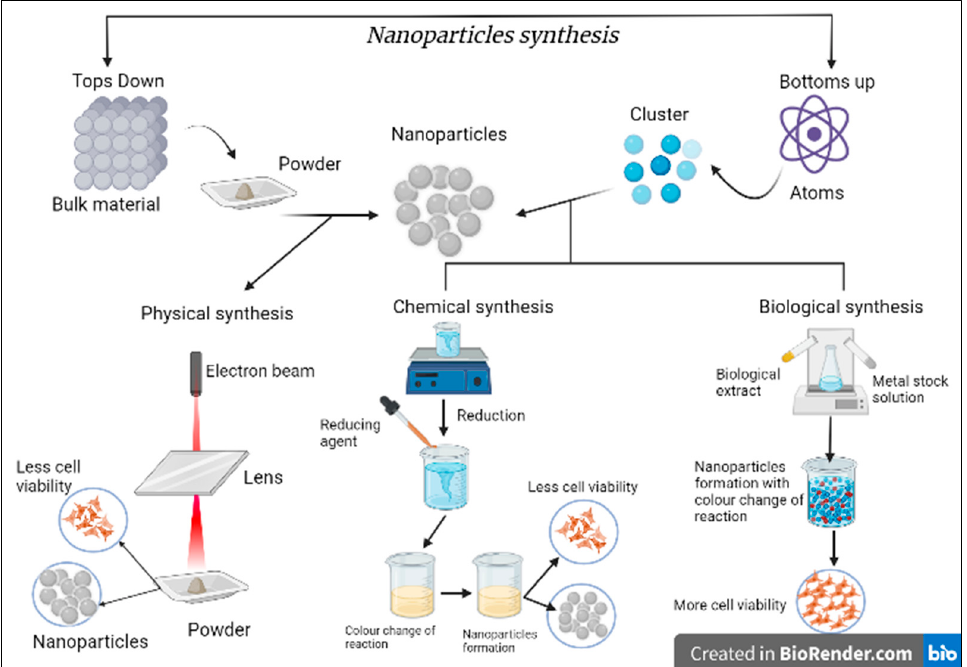
Figure 1. In brief, the AgNPs synthesis process by different synthesis approaches. The figure explains the top-down and bottom-up methods in detail. In the top-down method, it breaks down the bulk material into powder, and then this powder is used in the physical method of NP synthesis by laser ablation method. However, due to the toxicity, the cell viability is less. Likewise, in the bottom-up method, the atom form of the material is converted into a cluster. Then these clusters are used in synthesizing NPs by chemical or biological synthesis methods. In the biological method, cell viability is more than a chemical.